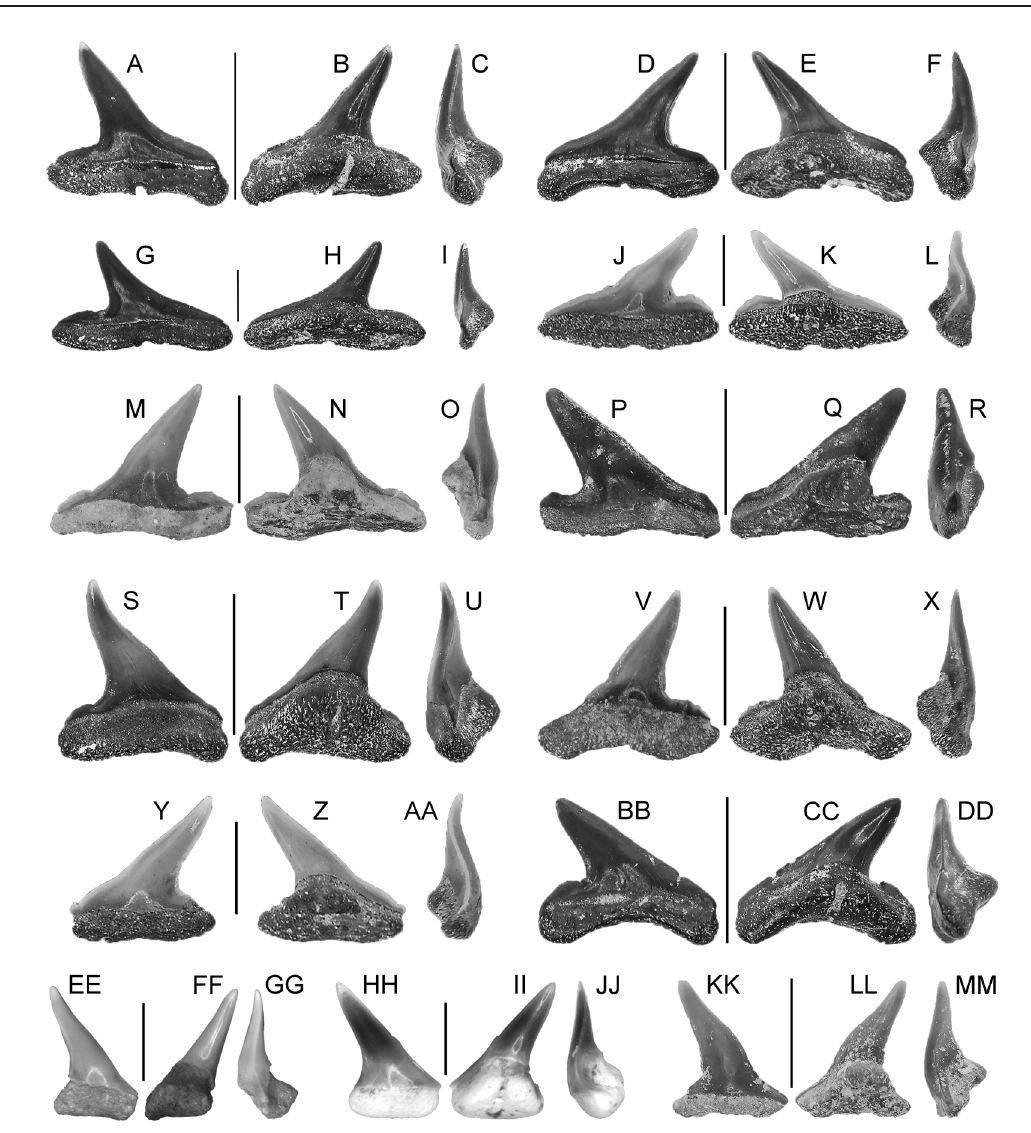
Fig. 29. Scoliodon conecuhensis Cappetta & Case, 2016, teeth. A–C . MSC 188.130, upper lateral